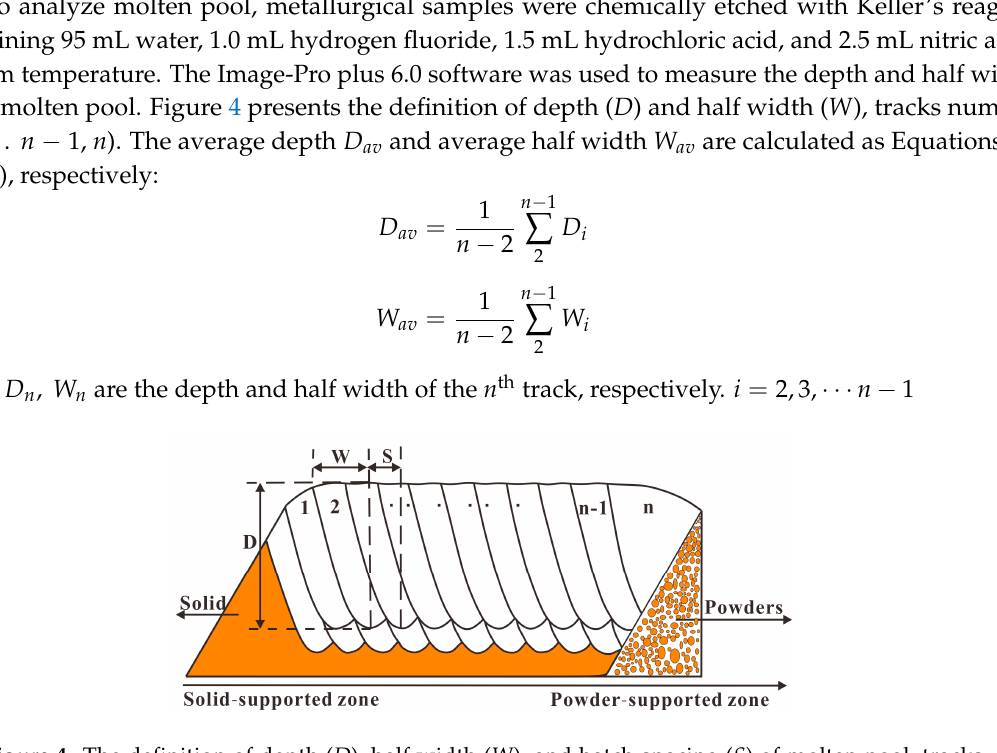
Figure 3. Definition of the parameters (cid:1844) (cid:3028) and (cid:1844) (cid:3053) .